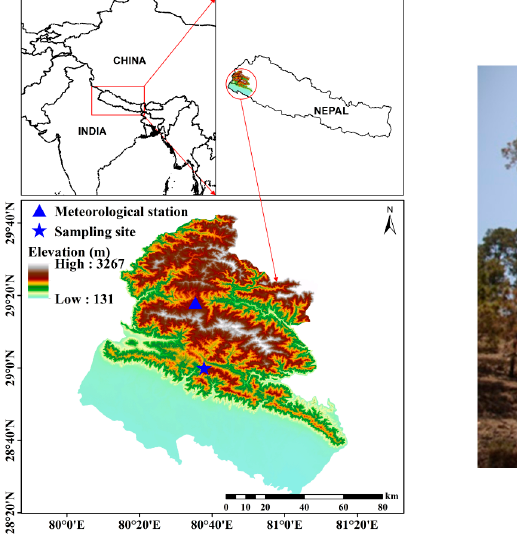
Figure 2. Climate diagram showing monthly mean temperature (1978–2016) and precipitation (1972– 2016) records in Dadeldhura, western Nepal.